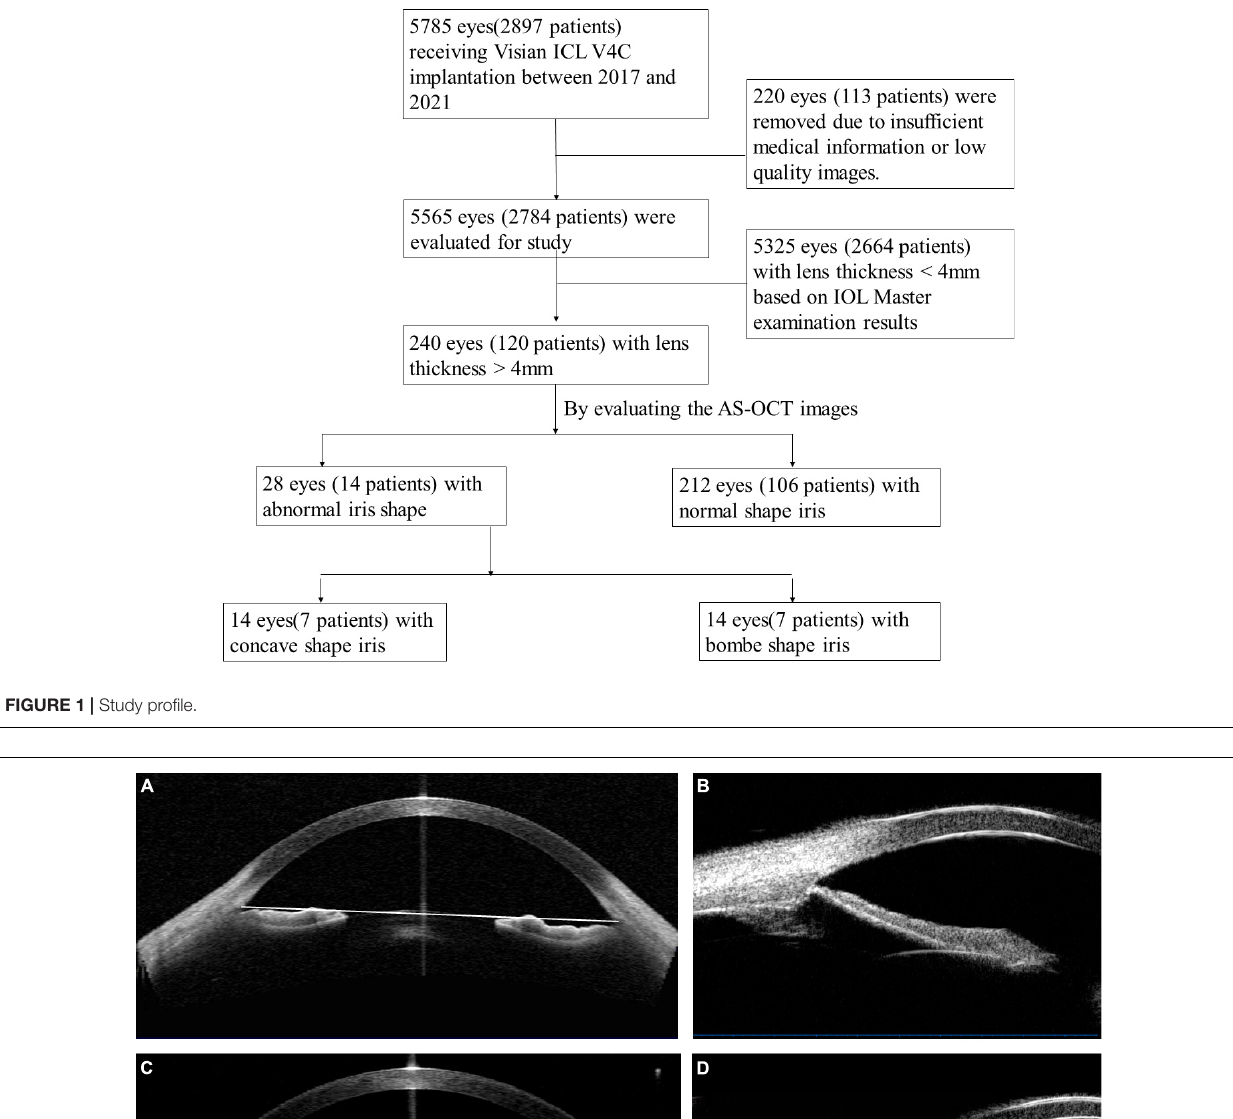
FIGURE 2 | The determination of the concave and convex iris shape based on the anterior-segment optical coherence tomography (AS-OCT) or ultrasound biomicroscopy (UBM) images. (A,B) Concave shape iris: most part of iris locating behind angle-to-angle (ATA) with a concave shape of the iris pigment epithelium, referring to a “bowing” away from the cornea. And a wide sulcus could be detected in (B) . (C,D) Convex shape iris: most part of iris locating before ATA with a convex shape of the iris pigment epithelium, referring to that the mid-peripheral iris pigment epithelium is “bowed” toward the cornea. Besides, convex shape iris with anteriorly positioned ciliary body was demonstrated in (D)